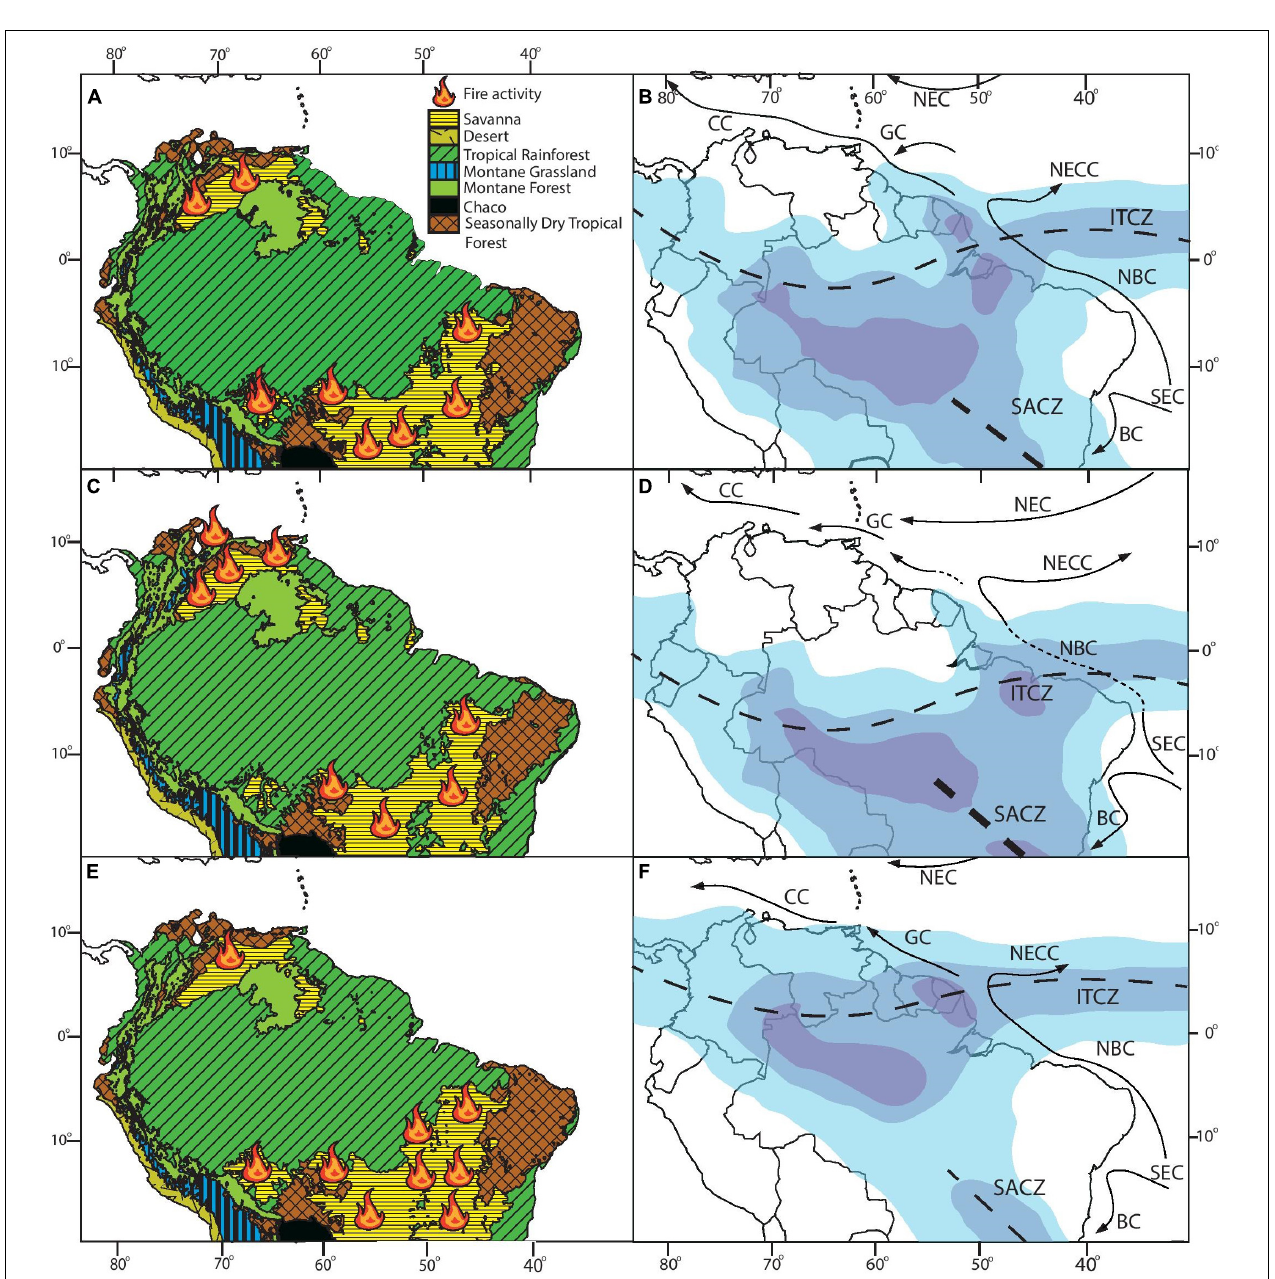
FIGURE 3 | Predicted continental response of vegetation, ocean currents and precipitation during abrupt climate events. The (A) modern day vegetation and fire (adapted from Pennington and Lavin, 2016), (B) December-February (DJF) precipitation patterns (blue: darker blue indicates more intense precipitation; adapted from Stríkis et al., 2015) and ocean currents (arrows) in tropical South America (adapted from Vink et al., 2001). (C) Predicted vegetation and fire activity during periods of Northern Hemisphere cooling. (D) Predicted precipitation and ocean currents during Northern Hemisphere cooling. (E) Predicted vegetation and fire activity during Northern Hemisphere warming. (F) Predicted precipitation and ocean currents during Northern Hemisphere